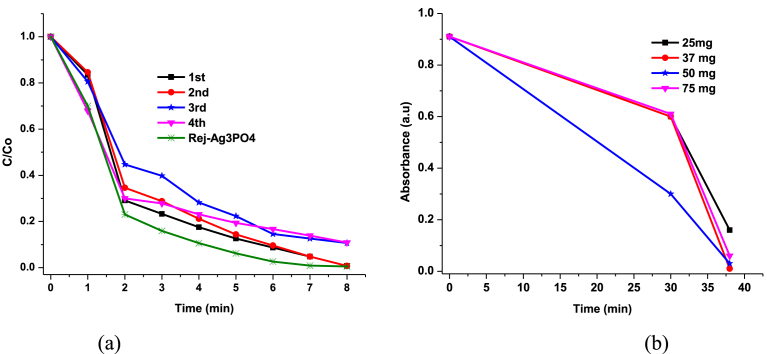
(a) Efficiency of Ag3PO4 with evolution of time; (b) Optimisation of photocatalyst loading.